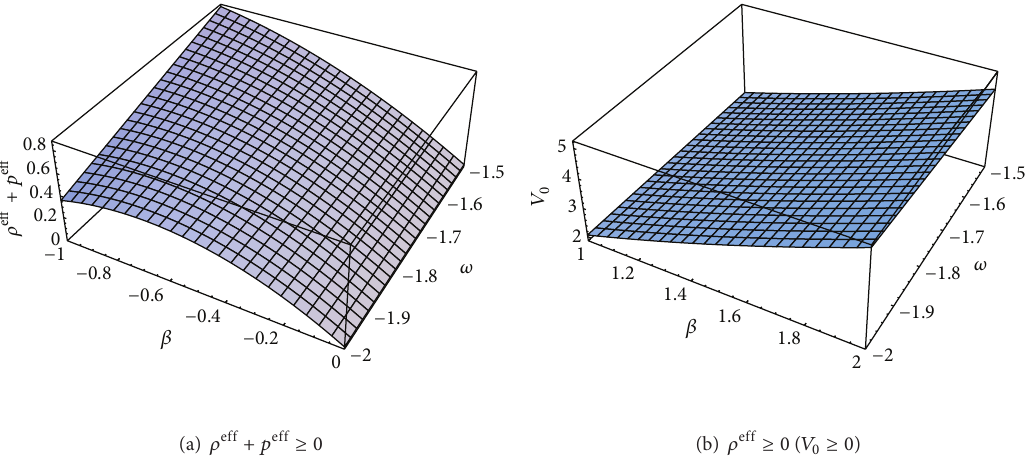
Figure 2: Plots (a) and (b) show WEC versus parameters 𝜔 and 𝛽 for 𝐻 0 = 0.718 and 𝑞 0 = −0.64